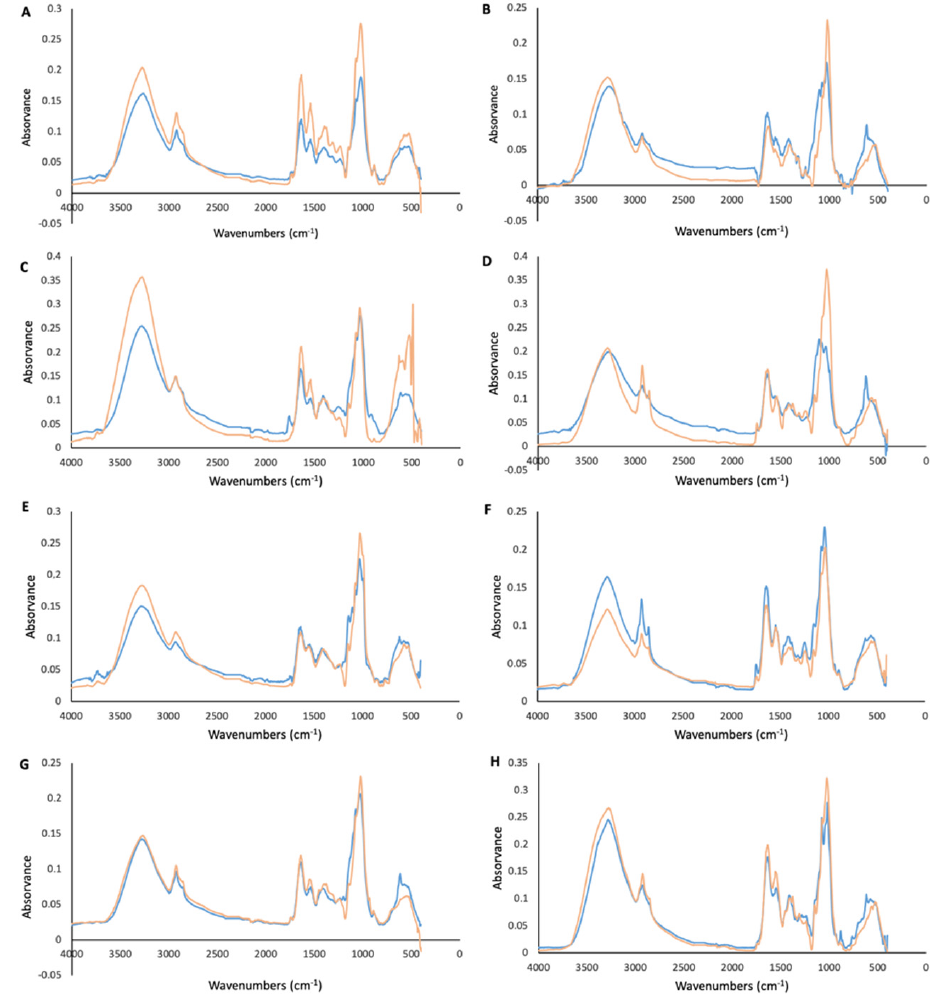
Figure 1. FTIR-ATR spectra of fungal mycelia grown with (blue) and without 3% sea salt (orange). ( A ) A. affinis (CMG 70); ( B ) A. protuberus (CMG 71); ( C ) C. rubrum (MUM 19.39); ( D ) E. cladophorae (MUM 19.33); ( E ) Paral. halima (MUM 20.56); ( F ) Paras. aestuarinum (MUM 19.35); ( G ) Pen. lusitanum (MUM 18.49); ( H ) T. aestuarinum (MUM 19.05).